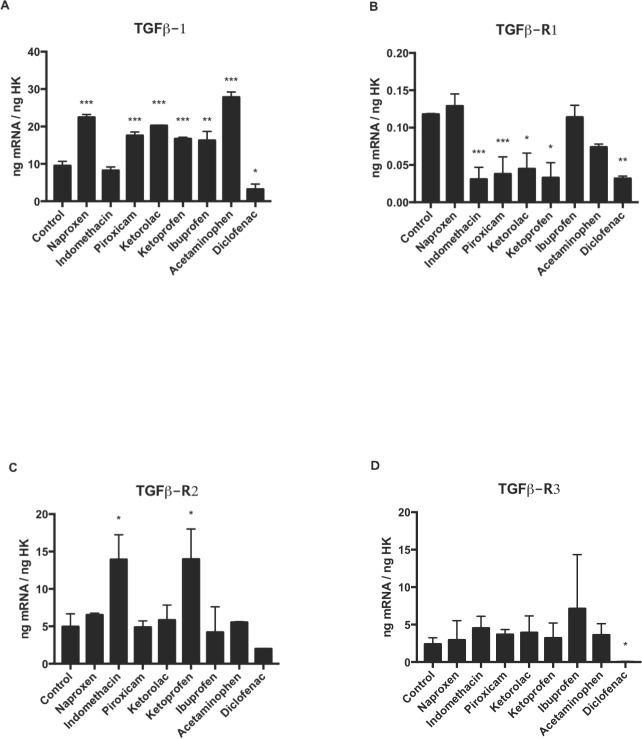
Expression of osteoblast genes treated for 24 h with acetaminophen, indomethacin, ketoprofen, diclofenac, ibuprofen, ketorolac, naproxen, or piroxicam (10 µM).(A) TFG-β1, (B) TFGβR1, (C) TFGβR2, (D) TFGβR3. Data are expressed as means ± SD of ng of mRNA per average ng of housekeeping mRNAs. *p ≤ 0.032, **p ≤ 0.006, ***p ≤ 0.001.